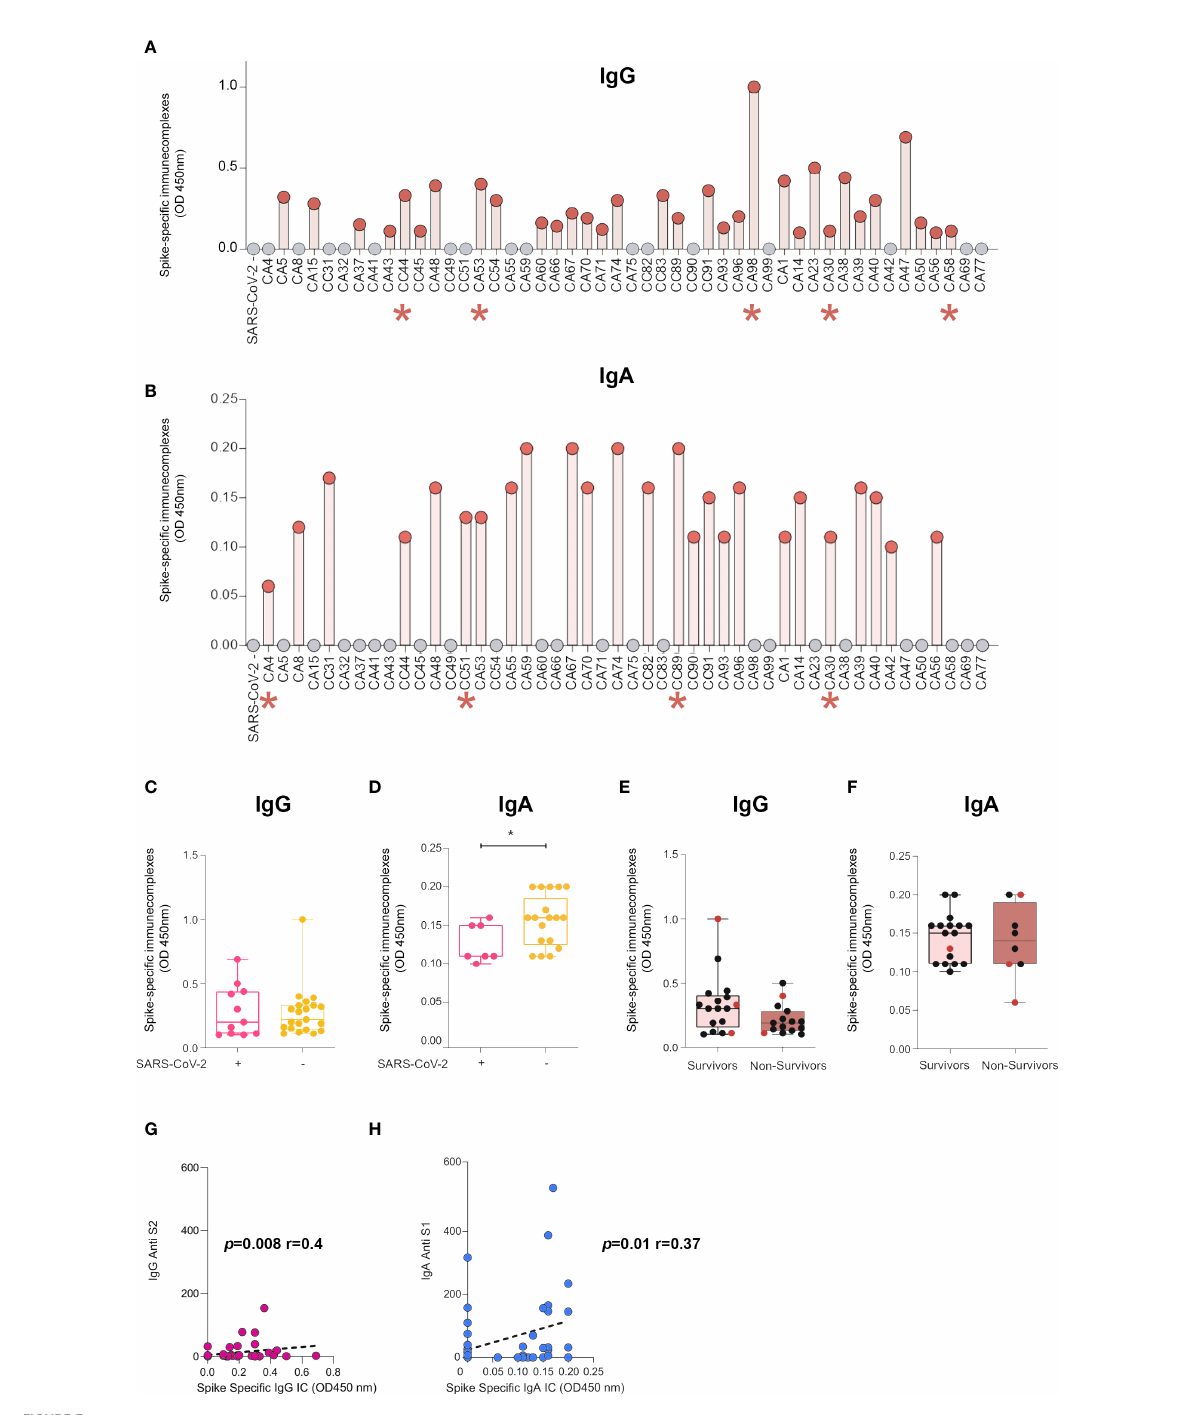
FIGURE 3 BAL from SARS-CoV-2-infected individuals contain IgG- and IgA-spike immune complexes (ICs). (A) Anti-spike IgG ICs were detected in 32 of the 48 samples analyzed by ELISA. Indicated with a red asterisk are individuals who had undetectable levels of IgG anti-spike/NP antibodies. (B) Anti-spike IgA ICs were detected in 25 of the 48 samples analyzed by ELISA. Indicated with red asterisk are individuals who had undetectable levels of IgA anti-spike/NP antibodies. (C, D) Comparison of presence of ICs made of spike with IgG (c) or IgA (D) in SARS-CoV-2+ BAL individuals and SARS-CoV-2 − BAL subjects. p -Values were calculated by using Mann – Whitney test: *, p < 0.05. (E, F) Comparison of presence of ICs made of spike with IgG (E) or IgA (F) in survivors vs non-survivors. (G, H) Correlation between speci fi c S1 and levels of ICs made of spike with IgG (G) or IgA (H) . Correlations were calculated using Spearman ’ s test. BAL, bronchoalveolar lavage; NP, nucleocapsid